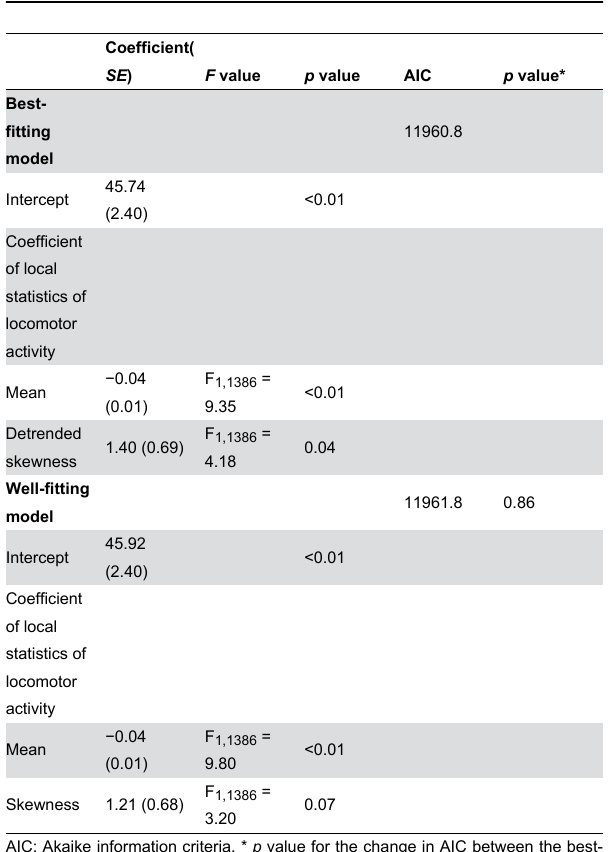
Table 3. Associations of depressive mood with local statistics of locomotor activity.